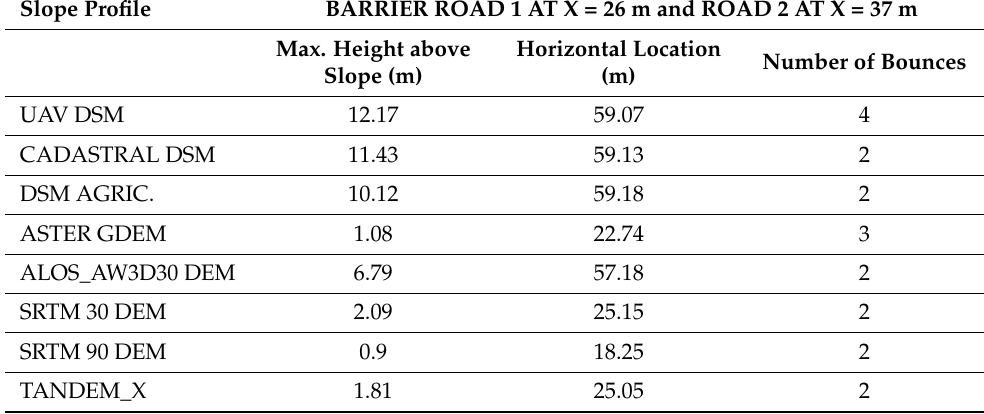
Table 9. Bounce height for the 2nd slope profile.